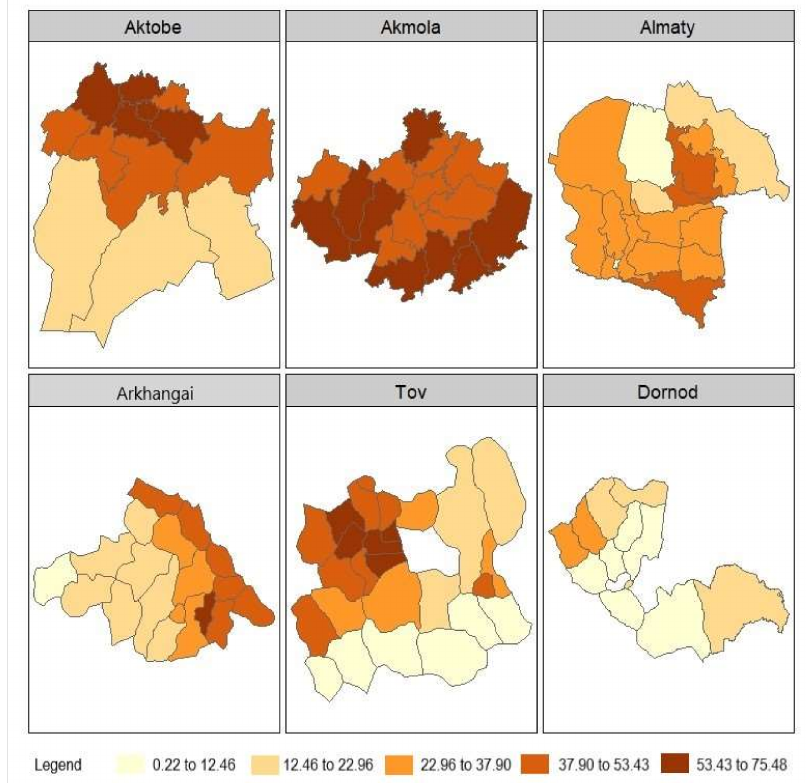
Figure 5. Spatial variations of land cover change intensity at county level for the six provinces in Kazakhstan and Mongolia. Jenks style class intervals were used for the continuous variable (accumulative land cover change intensity, accumulative iLCC ) toward a uniform color theme and to maximize the differences between